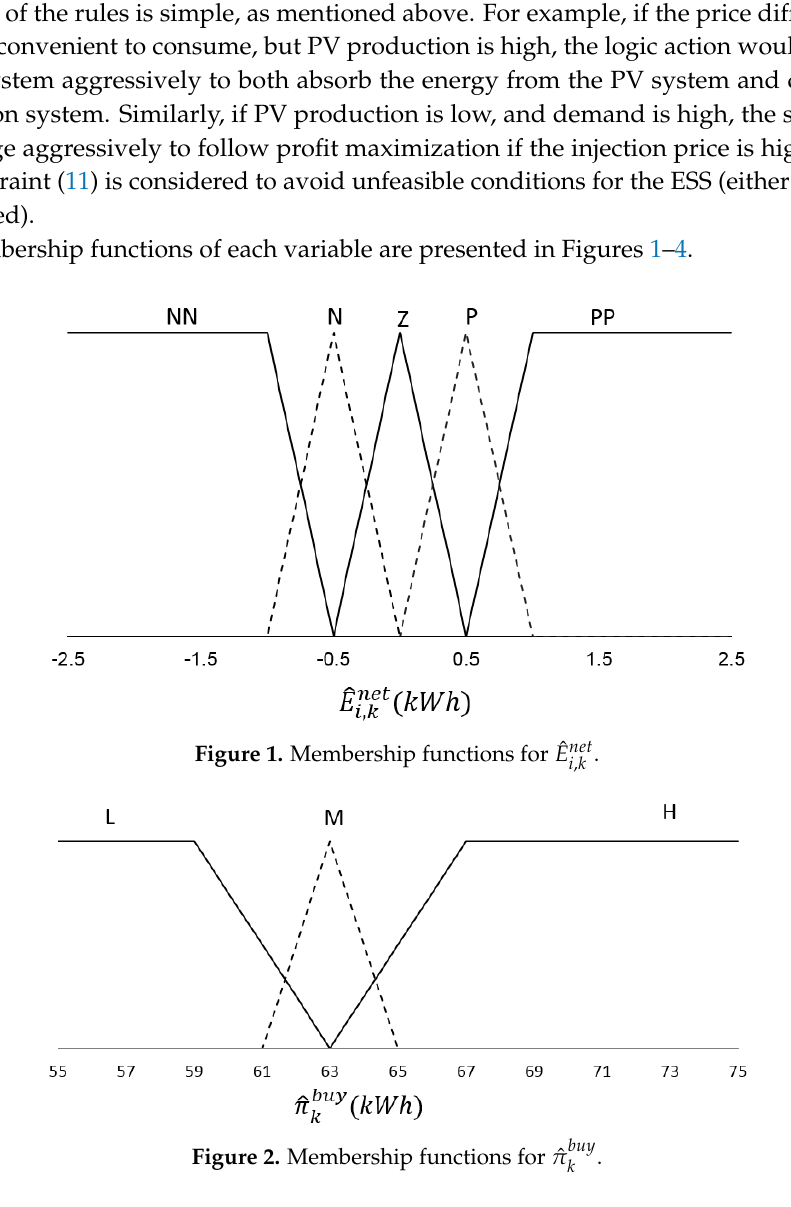
Figure 2. Membership functions for ˆ π buy